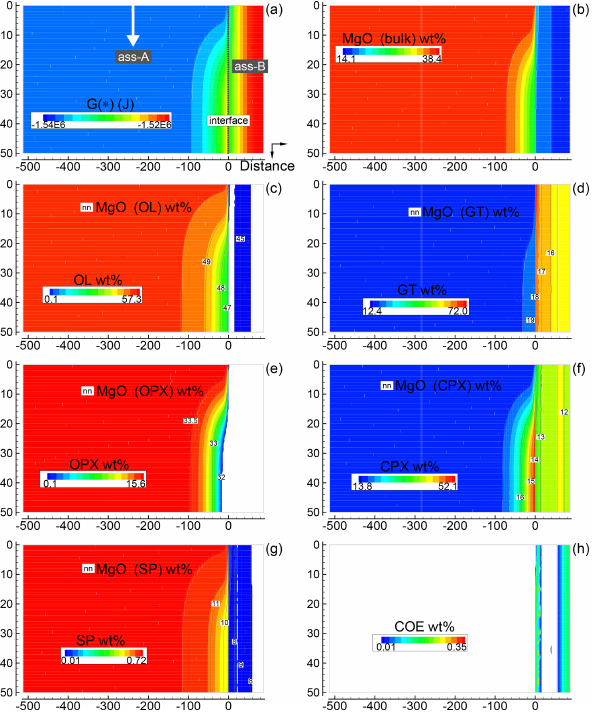
Figure 5. Solution of a 2-D model simulation at time 102400 (arbi- trary units). The starting proportion of the two assemblages is 5 : 1 ( f = 5). In the initial setup the two assemblages are separately in chemical equilibrium. At time 100000 a new assemblage A en- ters from the top side with velocity 0.00625 (arbitrary units). The new assemblage is assumed to have been equilibrated but never previously in contact with assemblage B (the composition of the new assemblage is the same as the assemblage in the initial setup). (a) Spatial variation of G( ∗ ) . (b) Local distribution of MgO in the bulk assemblage. Similar results are obtained for all the other ox- ides defining the bulk composition. An animation file and raw data for all nine oxides are available online following the instructions provided in the Supplement. (c–g) Local mineral distribution (color map) and contour lines for the abundance of MgO in the associated minerals. (h) Spatial distribution of coesite. Time and distance in arbitrary units. Pressure and temperature are fixed at 40kbar and 1200 ◦ C. The rest of the parameters for the numerical model are defined in the main text.